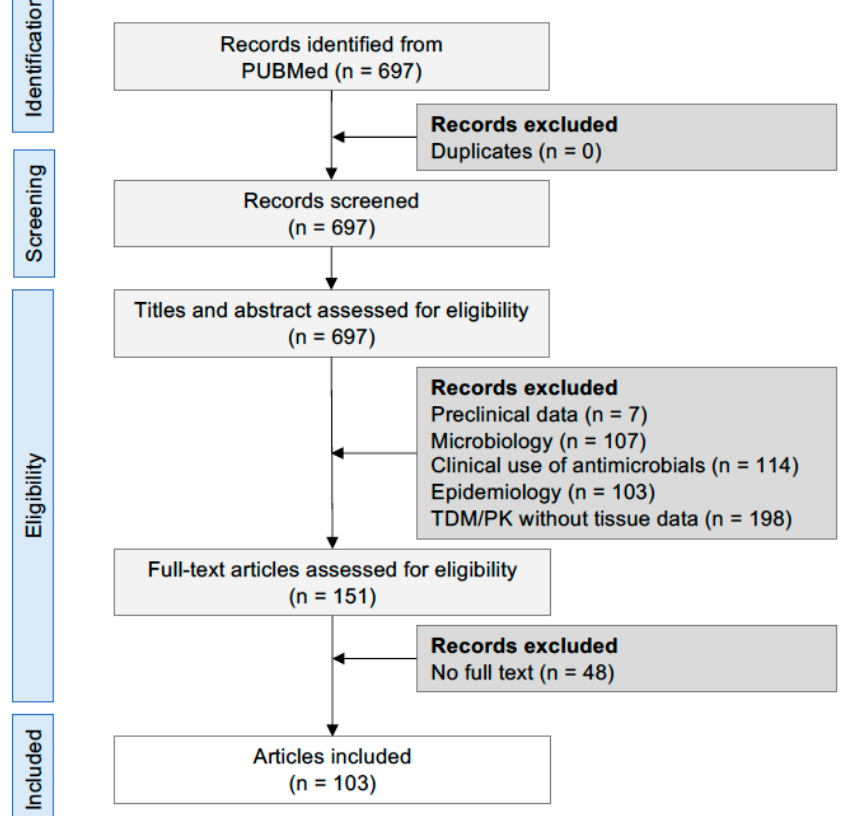
Figure 1. PRISMA flow diagram. Abbreviations: TDM, therapeutic drug monitoring; PK, pharmacokinetics.